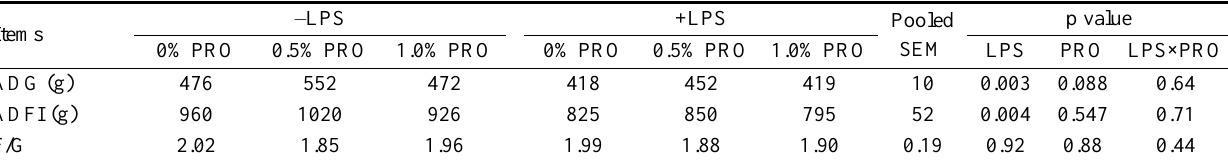
Table 3. Effects of L-proline supplementation on growth performance of weanling piglets after LPS challenge or saline injection (10-20 d) 1